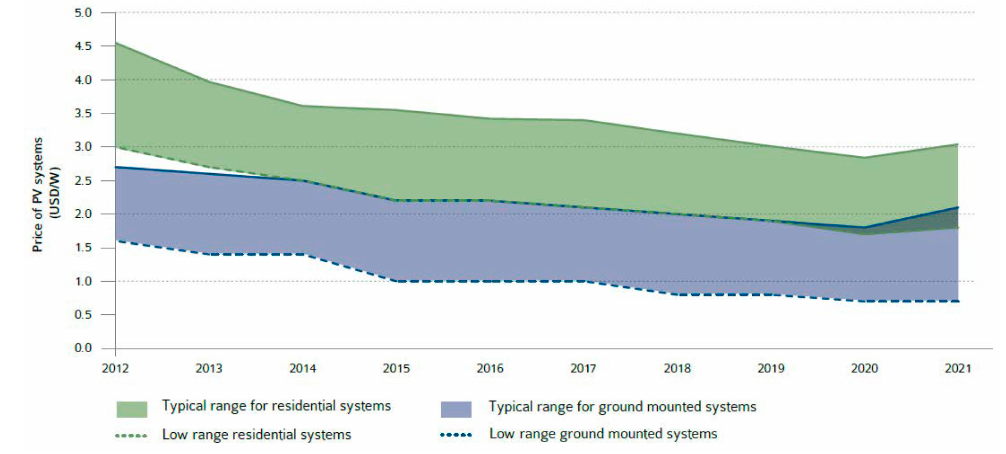
Figure 6. Evolution of residential applications and utility scale prices of PV systems